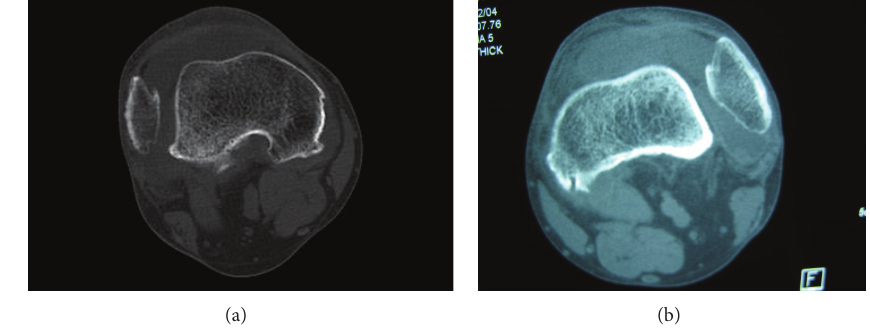
Figure 3: CT images of right (a) and left (b) knees.